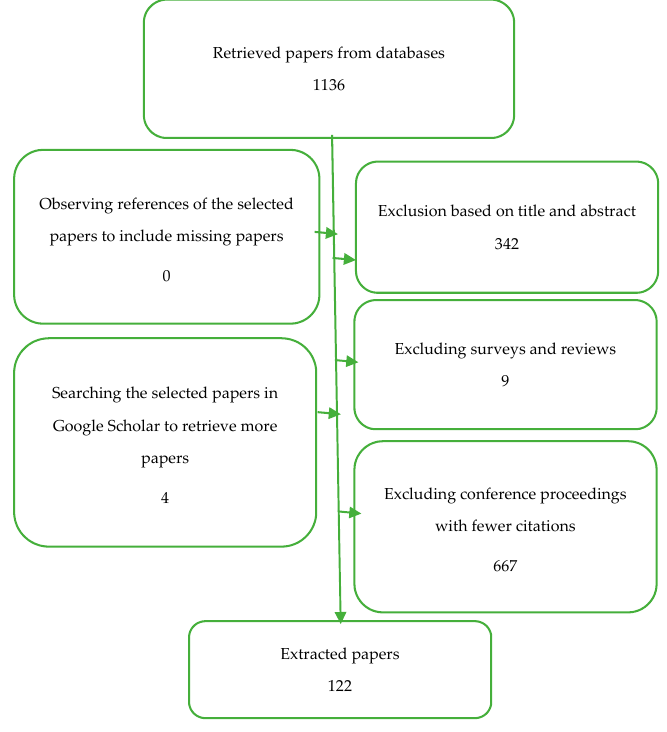
Figure 1. Data extraction strategy.